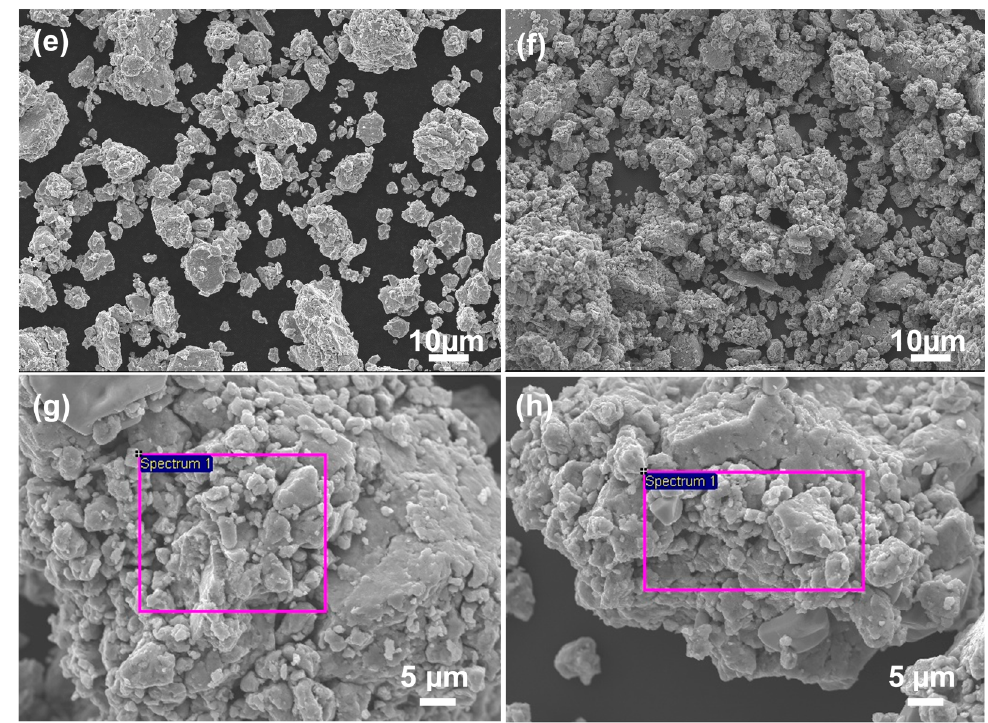
Figure 1. SEM of starting powders in ( a ) TiH 2 and ( b ) copper powders. SEM images of composite powders milled for 10 h, with 10 vol % TiC in ( c ) Cu–TiH2–C and ( d ) Cu–Ti–C; and with 20 vol % TiC in ( e ) Cu–TiH2–C and ( f ) Cu–Ti–C. Higher-magnification SEM images; the rectangles mark areas; from which EDS spectra were taken ( g ) Cu–TiH2–C and ( h ) Cu–Ti–C.